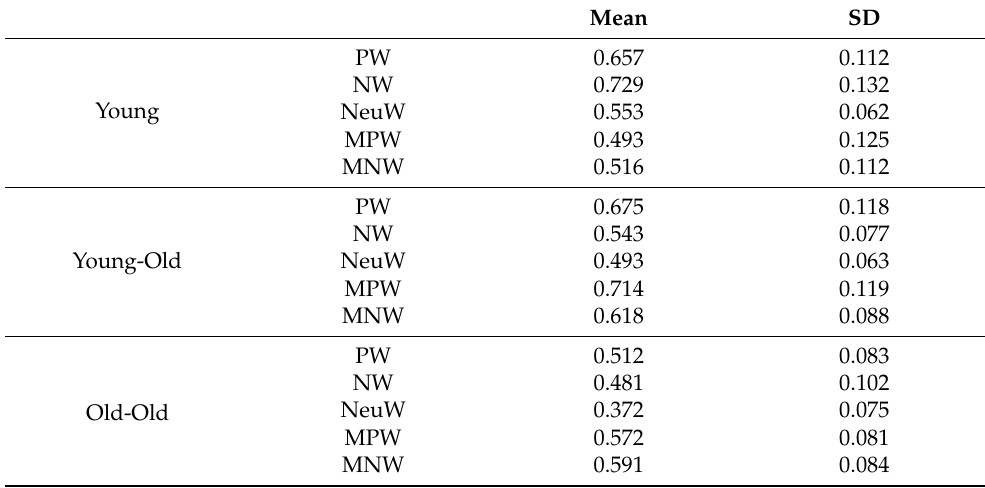
Table 2. Age x type of valence. PW = positive words; NW = negative words; NeuW = neutral words; MPW = mixed-positive words; MNW = mixed-negative